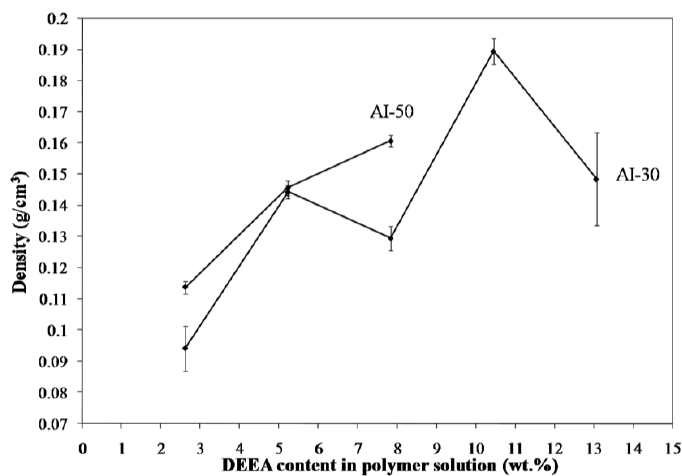
Figure 8. Density as a function of amine content for a 5 wt.% polymer material.